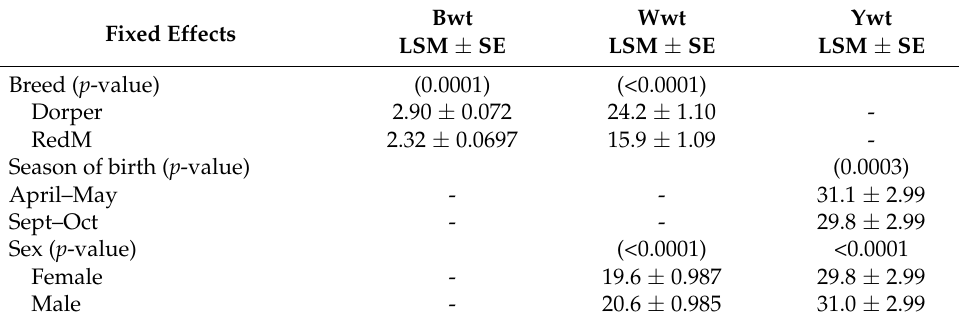
Figure 4. Effect of dam age on the yearling weight. Table 4. Factor difference per